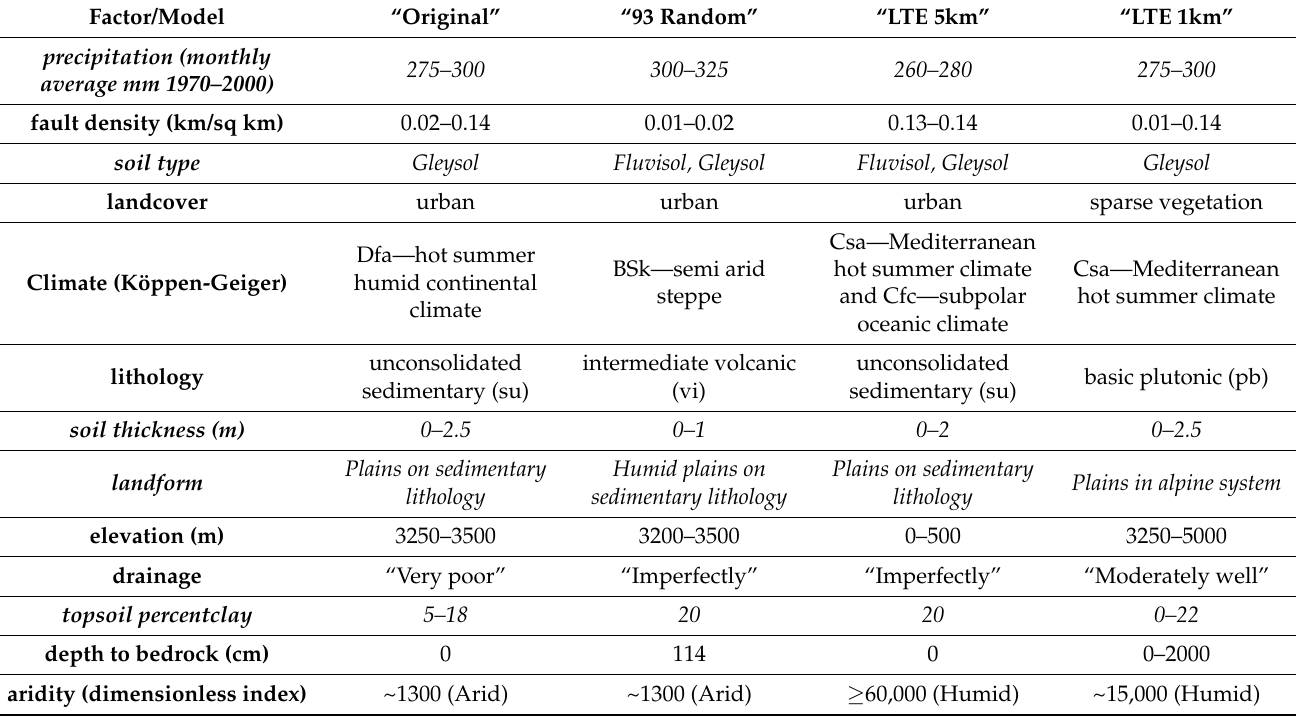
Table 9. Comparison of factor classes with highest significance to susceptibility in four models. Italicized factors are those with closest